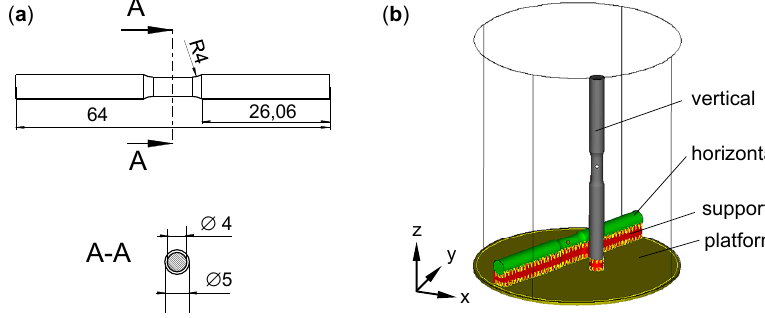
Figure 3. ( a ) Tensile specimen; testing area 8 mm long and 4 mm diameter, all dimensions in mm; ( b ) orientation of tensile specimens relative to build chamber of LBM machine.